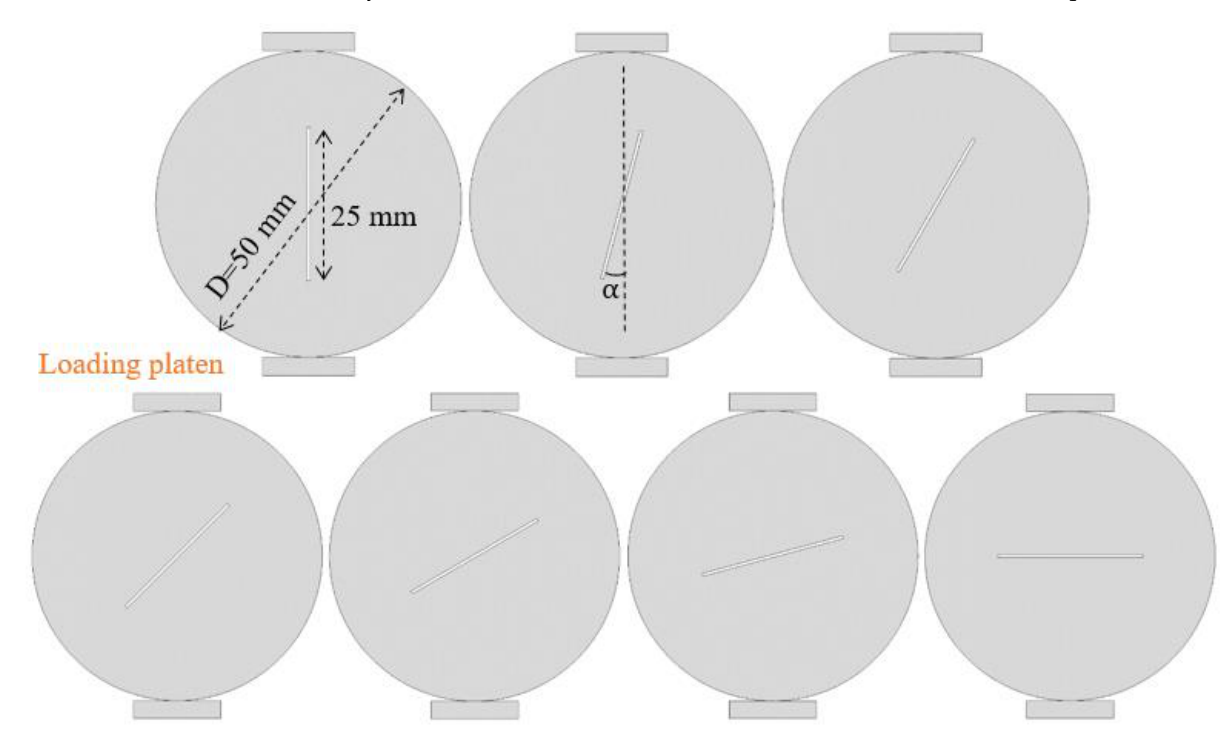
Figure 1. Seven Brazilian disc models with cracks of different angles. The crack angles are 0°, 15°, 30°, 45°, 60°, 75°and 90°, respectively. Table 1. Material property of model.